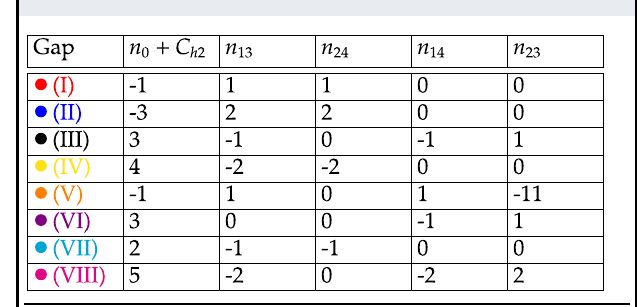
Table 1 Gap labeling for β = π /2, a 1 = a 2 = 1 lattice.